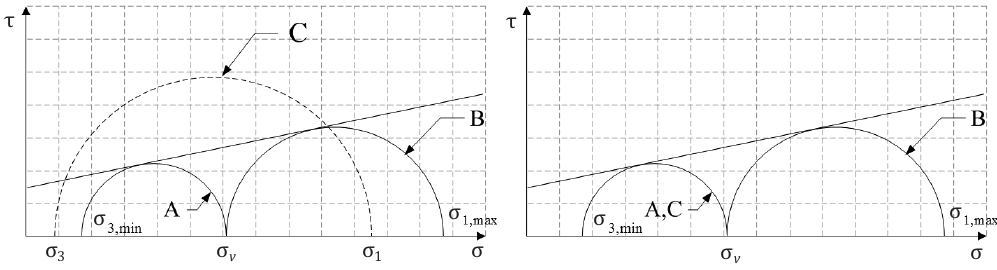
a) the stress state 1 before the correction b) the stress state 1 after the correction